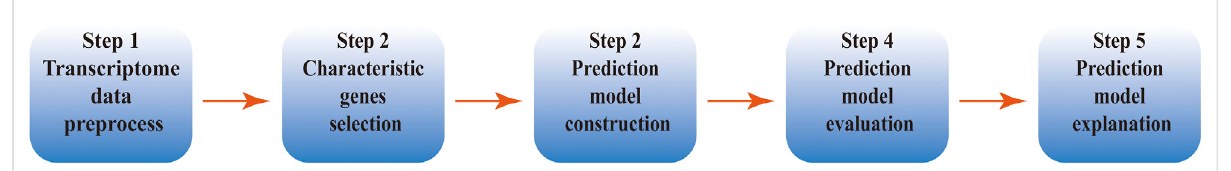
FIGURE 1 Work fl ow of risk prediction for the transcriptomic data based on bioinformatics and machine learning